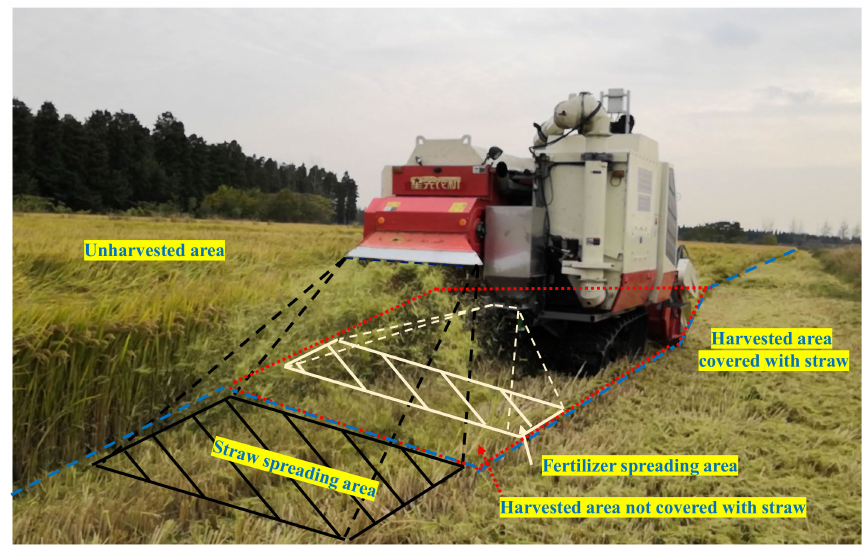
Figure 2. Relation among fertilizer spreading area, straw spreading area, and unharvested